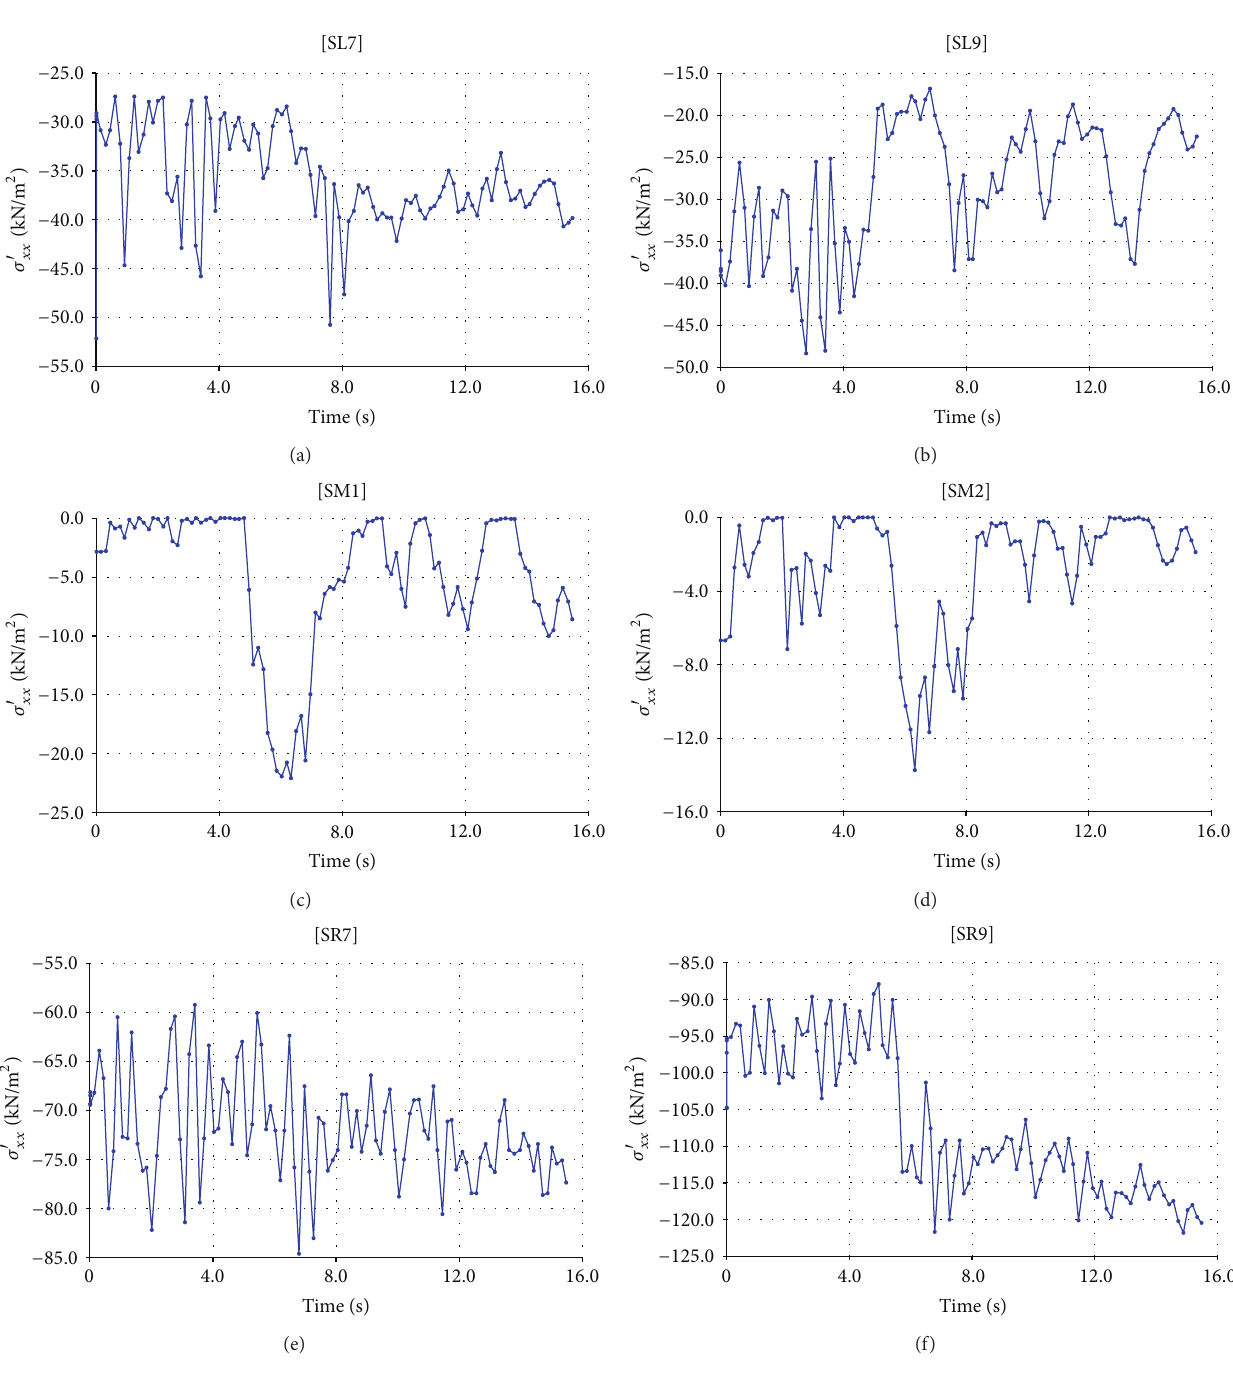
Figure 11: Stress-time curves for Upper San Fernando